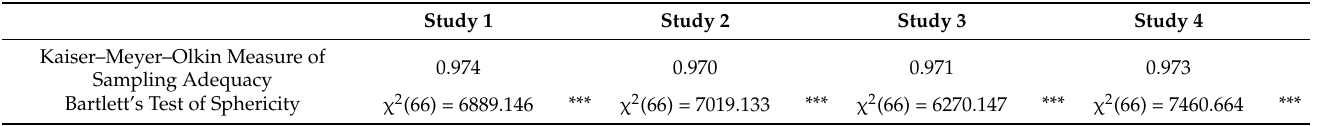
Table 1. Sampling adequacy